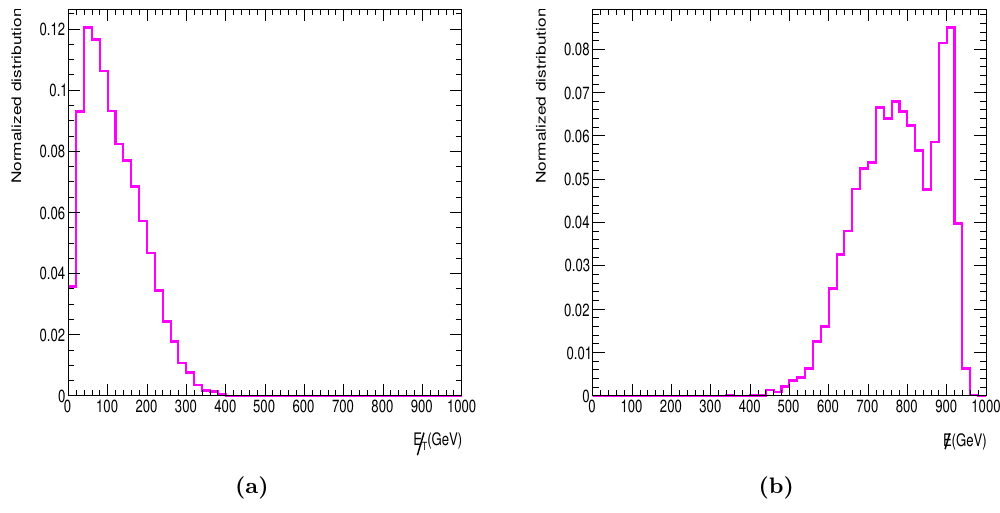
Figure 6. Same as figure 3, with { m DM duction cross-sections for the heavier HDSP is taken to be one-quarter of that of the lighter ones √ at s = 1000